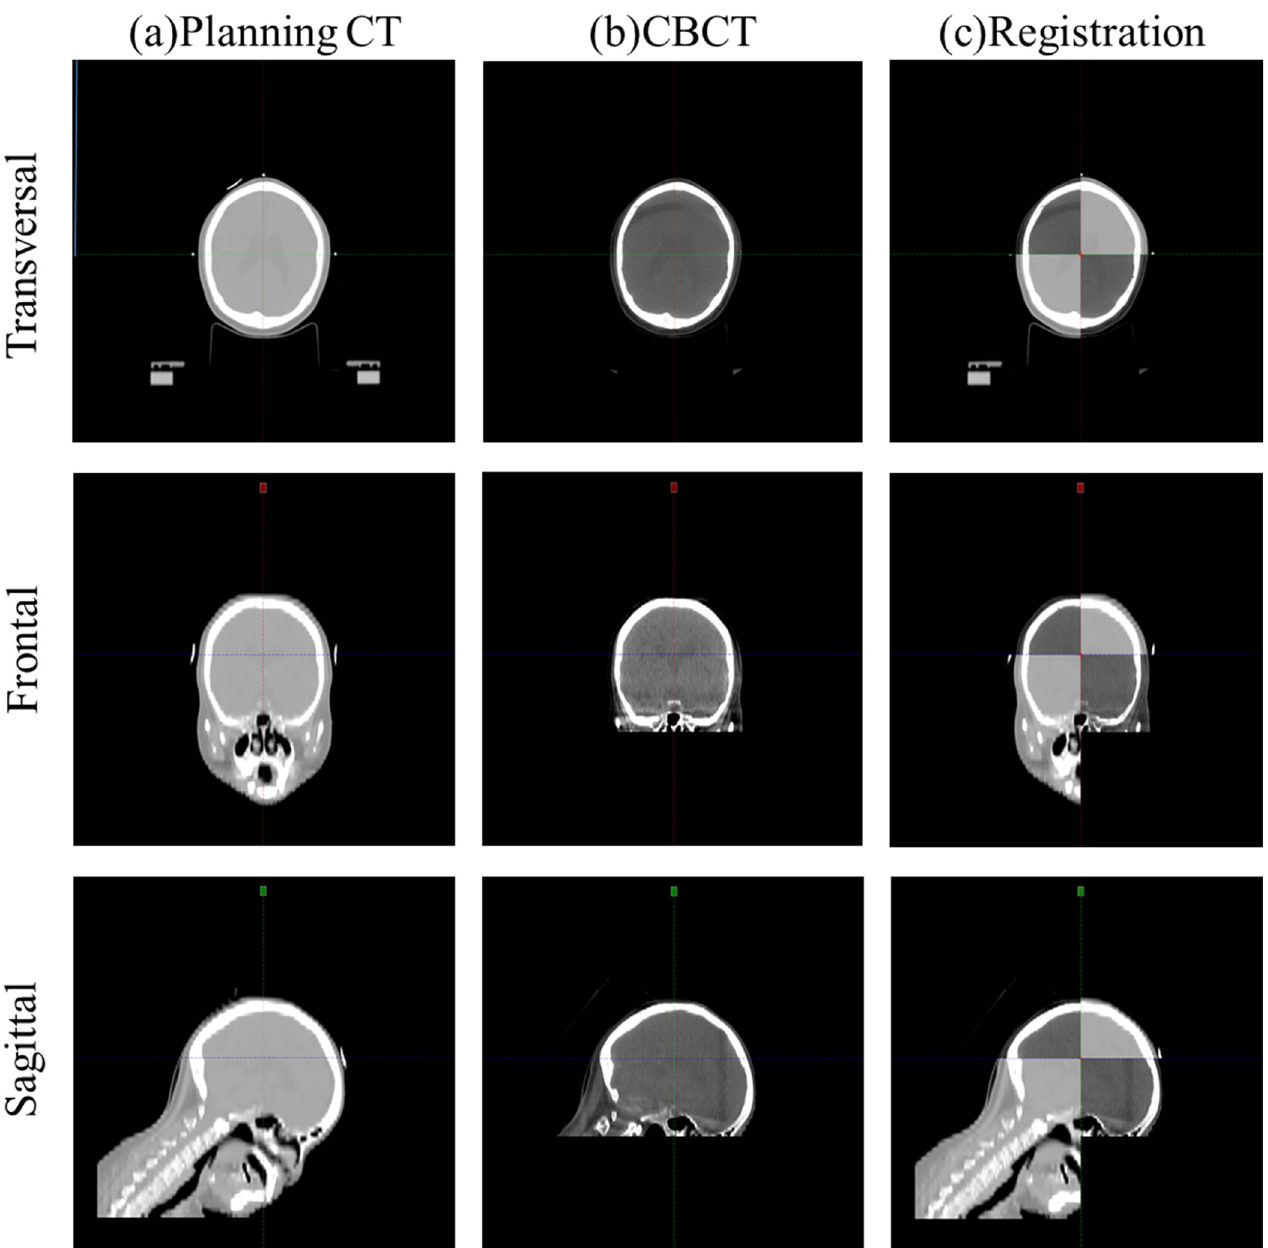
Fig 3. Image registration using the planning computed tomography (CT) and cone beam CT (CBCT) in the ht-SP. (A) Planning CT, (B) CBCT, and (C) registration image. https://doi.org/10.1371/journal.pone.0271077.g003 Herk et al. reported that because the margin excludes rotational errors and shape deviations, this recipe must be considered as a lower limit for safe radiotherapy.